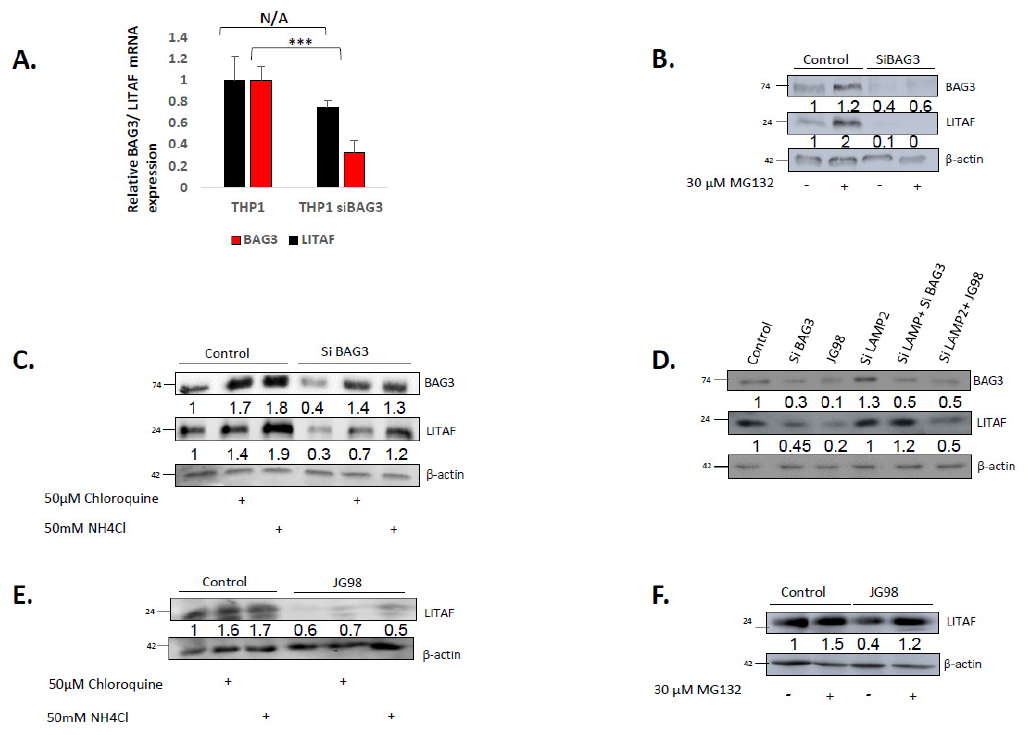
Figure 3. Mechanism of downregulation of LITAF by disruption of Hsp70–Bag3. ( A ) Silencing of Bag3 does not affect mRNA levels of LITAF. Differentiated THP1 macrophages were transfected with BAG3 or control siRNAs for 72 h followed by real-time PCR analysis of LITAF mRNA levels. mRNA levels were calculated using two-sample t -test statistics. Depicted is the mean relative expression (log2) ± s.e.m. *** p ≤ 0.001 and N/A p ≥ 0.05. ( B ) Inhibition of proteasome does not restore levels of LITAF upon silencing of Bag3. THP1 was transfected with the corresponding siRNAs for 72 h, followed by incubation with 30 µ M MG132 for an additional 24 h, levels of indicated proteins were detected by immunoblot analysis. ( C ) Inhibition of lysosome significantly restores the levels of LITAF upon silencing of Bag3. THP1 was transfected with the corresponding siRNAs for 72 h, followed by incubation with 50 µ M chloroquine for an additional 4 h or 50 mM NH4Cl for 30 min. Levels of indicated proteins were detected by immunoblotting. ( D ) Upon Bag3 silencing LITAF is downregulated via the CMA. THP1 were transfected with Bag3, Lamp2a, or control siRNA or their combinations for 72 h. Alternatively, cells were treated with 5 µ M JG98 for 24 h in the presence and absence of Lamp2 siRNA, and the levels of indicated proteins were detected by immunoblot analysis. While silencing of Lamp2 restores levels of LITAF upon Bag3 silencing, it does not affect LITAF levels upon inhibition of Hsp70. ( E ) Inhibition of lysosome did not restore levels of LITAF upon downregulation of Hsp70 by JG98 ( F ) Inhibition of proteasome restores LITAF levels upon inhibition of Hsp70. Cells were treated with 5 µ M JG98 or left untreated for 24 h, followed by incubation with 30 µ M MG132 for an additional 24 h, levels of indicated proteins were detected by immunoblot analysis. Numbers under the blot lanes represent relative expression normalized to β -actin. Uncropped WB Figure